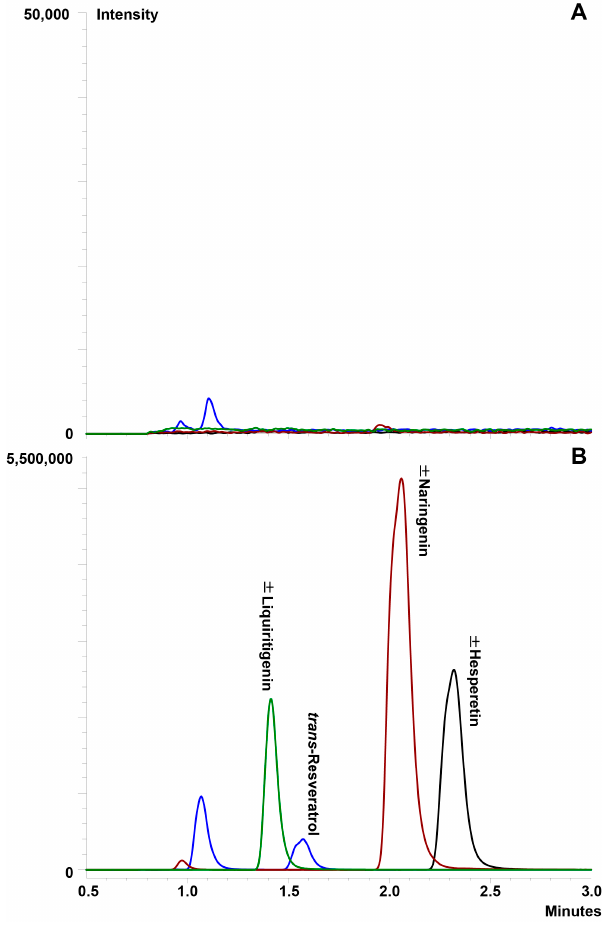
Figure 3. Representative chromatograms of ±hesperetin, trans-resveratrol and ±naringenin in serum: ( A ) blank serum demonstrating no interfering peaks co-eluted with the compounds of interest; and ( B ) serum containing polyphenols (20 µ g/mL) and the internal standard.